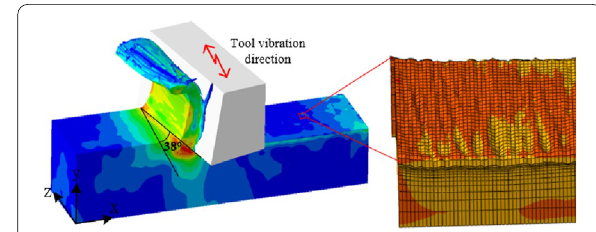
Figure 6 Imitated diagram of workpiece surface roughness